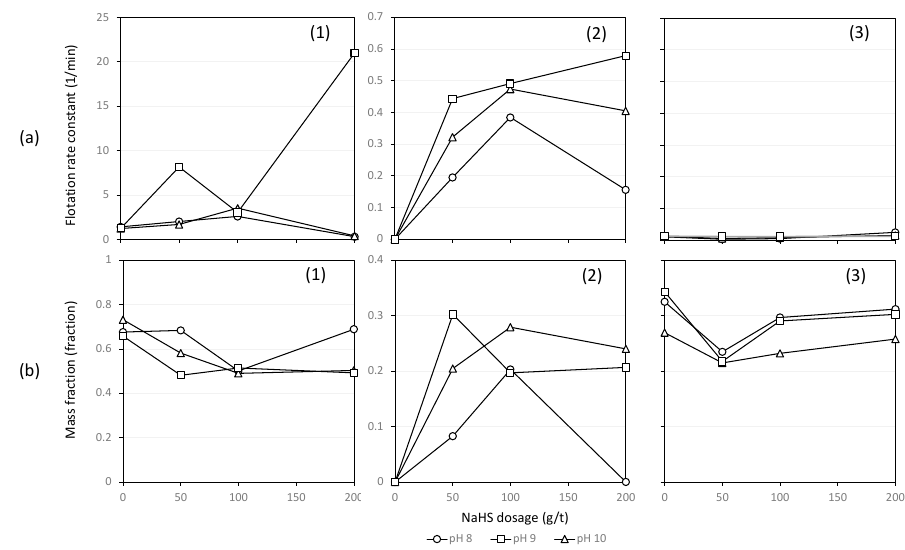
Figure 12. The chalcopyrite results of ( a ) flotation rate constants, (1) K 1 , (2) K 2 , (3) K 3 , and ( b ) mass